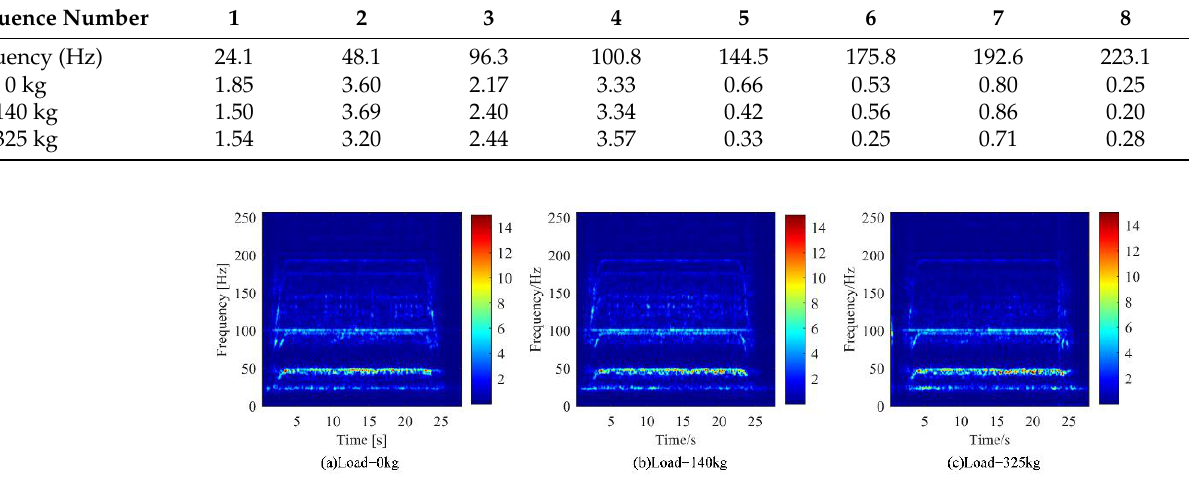
Figure 8. Vibration spectrum diagram of elevator main engine with different loads. ( a ) Motor running under 140 kg load condition. ( b ) Motor running under 325 kg load condition.